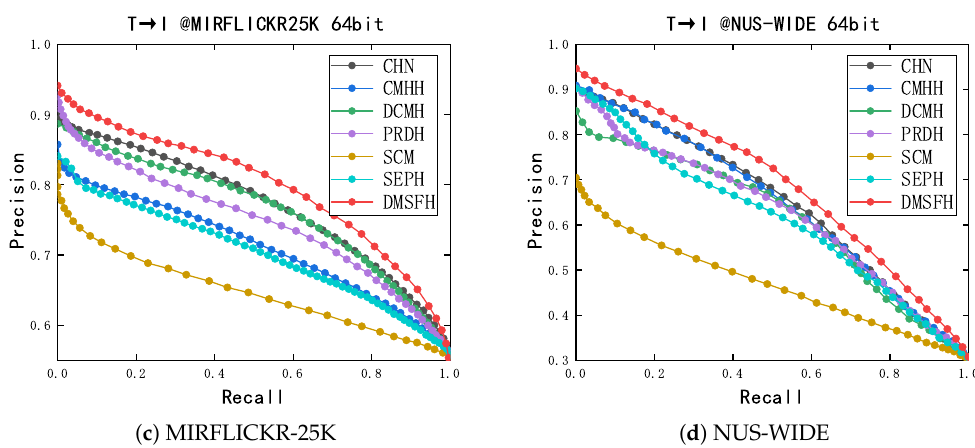
Figure 5. Precision–recall curves on MIRFLICKR-25K and NUS-WIDE datasets. I → T query: ( a , b ); T → I query: ( c , d ). The code length was 64 bits.